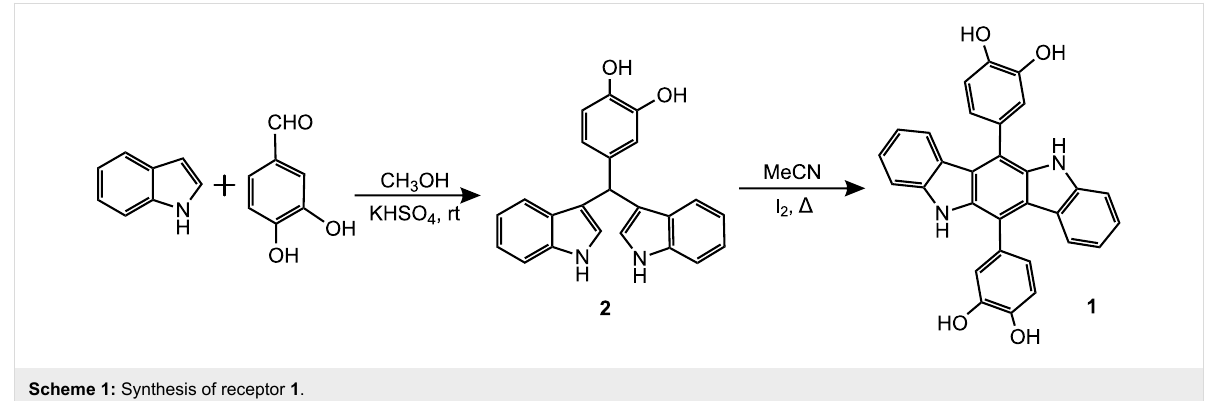
Scheme 1: Synthesis of receptor 1 .